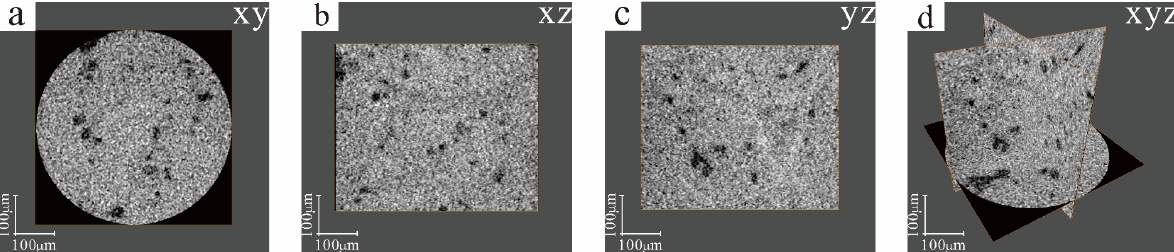
Figure 18. Micro-CT slice image of sample HZ-2 in the Huize lead–zinc deposit. ( a ) Sample xy section Micro-CT scan image; ( b ) Sample xz section Micro-CT scan image; ( c ) Sample yz section Micro-CT scan image; ( d ) Micro-CT scanning mosaic image of sample xyz section